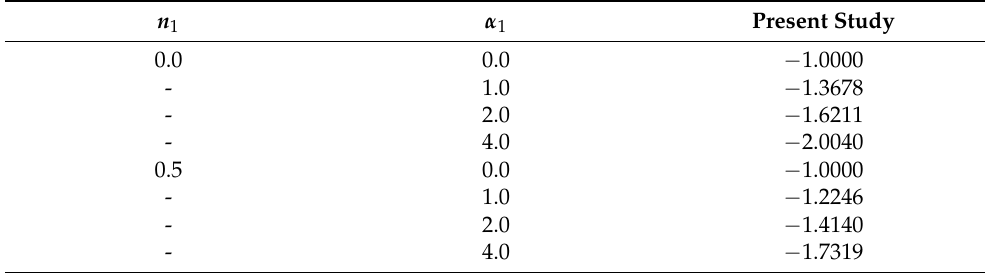
√ Table 3. Assessment of Re C f with published results for sundry values of α 1 and n 1 in the neglecting of A 1 , A 2 and β